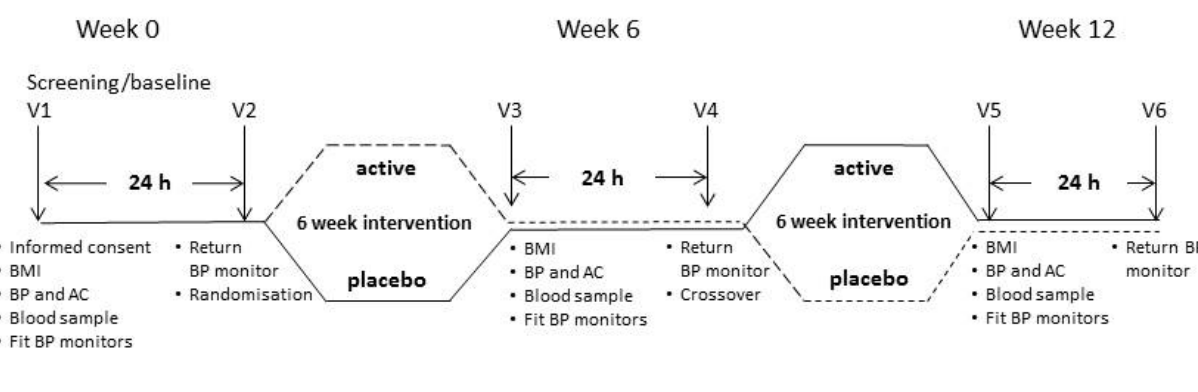
Figure 1. Outline of study design. During baseline/screening Visit 1 (Week 0), participants underwent assessments of body mass index (BMI), clinic blood pressure (BP), arterial compliance (AC), 24-h ambulatory BP (BP monitors), fasting blood lipids, glucose and insulin levels to confirm suitability before randomisation to treatment. These assessments were repeated at Visit 3 (Week 6), before participants switched over to the alternate treatment (Visit 4, Week 6) and again at Visit 5 (Week